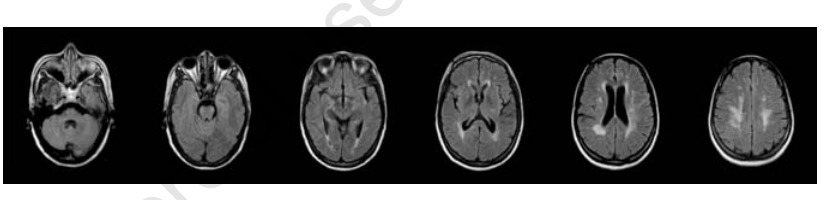
Figure 2. Follow-up magnetic resonance imaging after eight months, showing significant diminution of hyperintensity on the FLAIR sequence, except for some leukoaraiosis. The reversible changes of clinical symptoms and radiological findings after the normalization of blood pressure are indicative of hypertensive